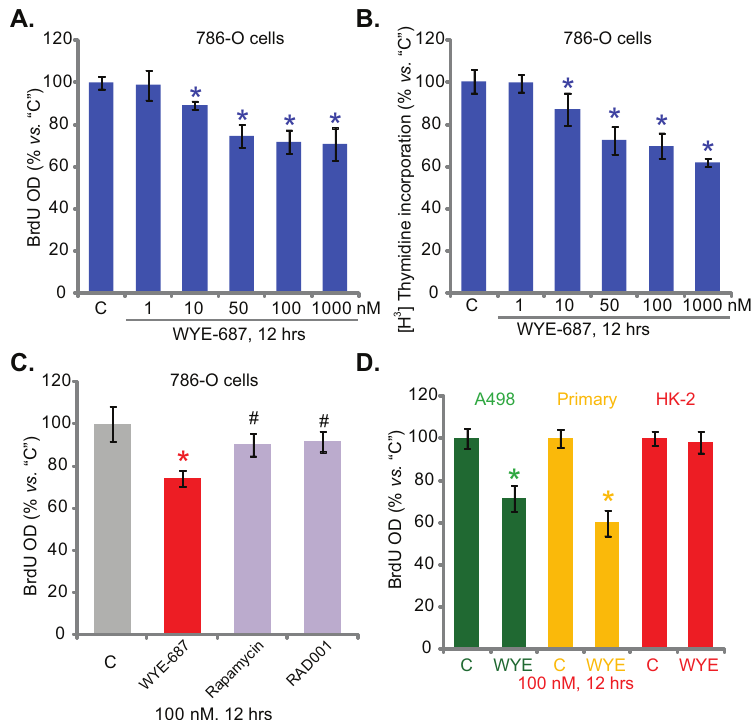
Fig 3. WYE-687 inhibits human RCC cell proliferation. RCC cell lines (786-O and A498), primary human RCC cells, or HK-2 tubular epithelialcells were treated with indicatedconcentrations of WYE-687, rapamycin or RAD001for appliedtime, cell proliferation was tested by listed assays (A-D, n = 5). * p < 0.05 vs. untreated control group (“C”). # p < 0.05 vs. WYE-687 group